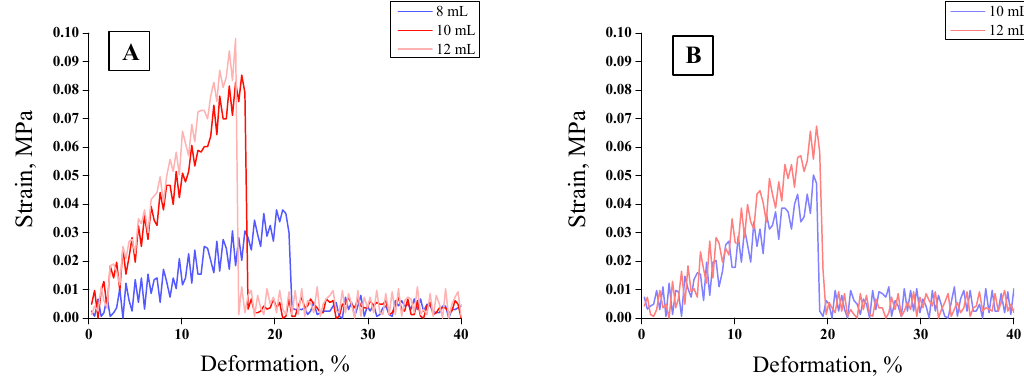
Figure 12. Stress–strain characteristics of hydrogels with different contents of PEGDA 700: ( A ) unmodified, ( B ) modified.